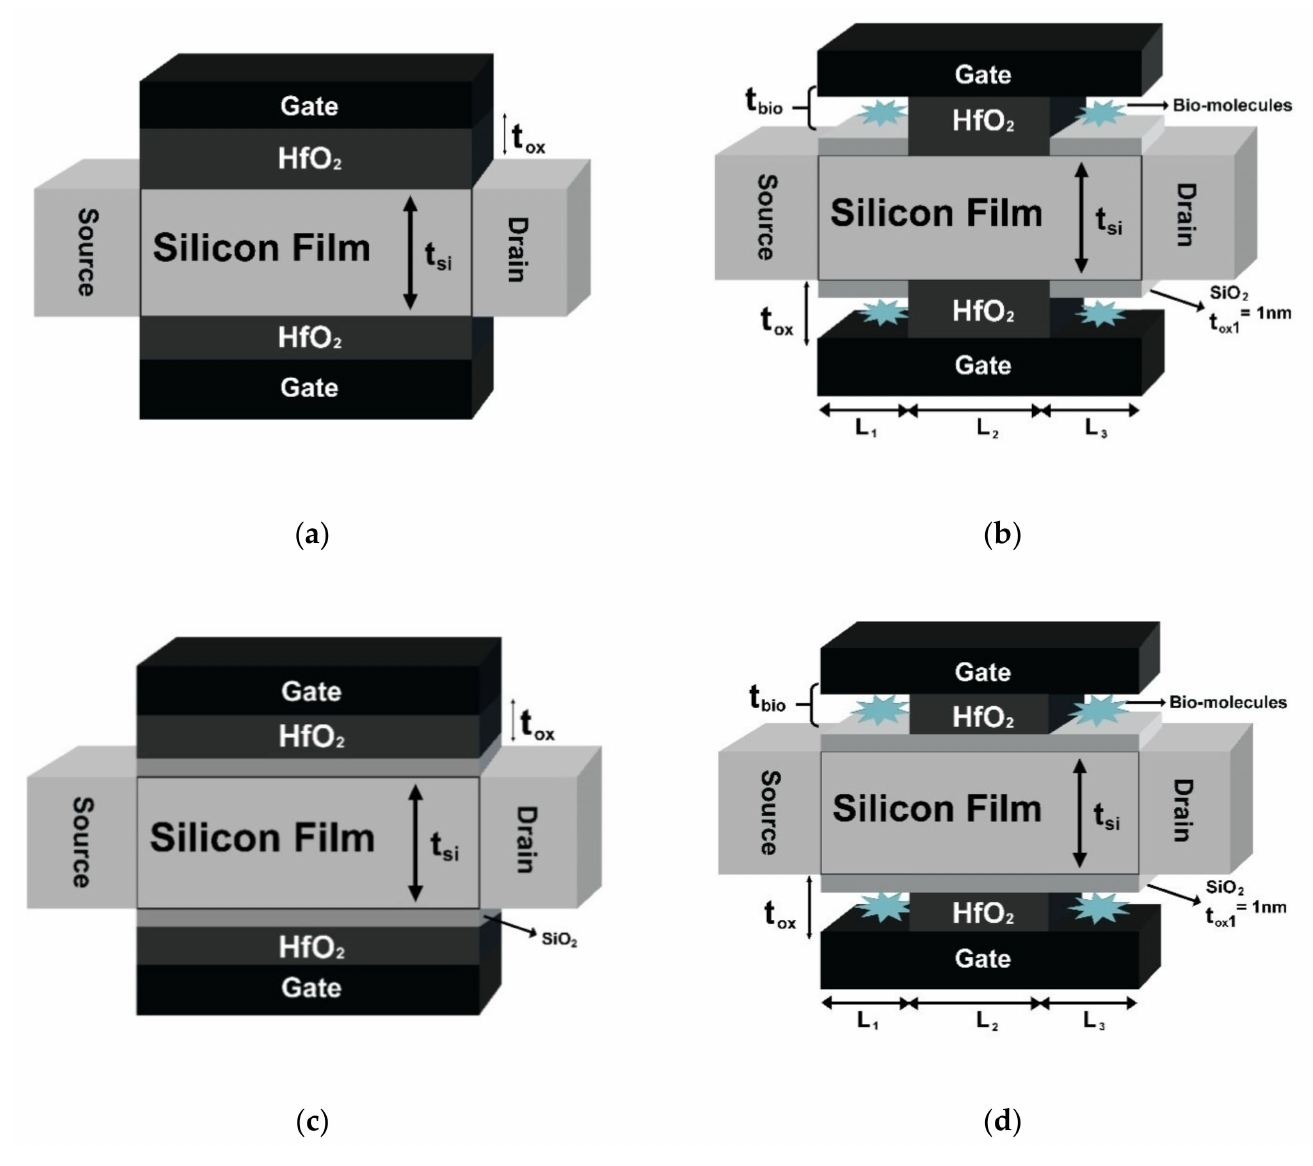
Figure 1. Device structure of ( a ) n-type junctionless DM-DG-MOSFET; ( b ) n-type junctionless DG- MOSFET-based biosensor with cavity; ( c ) n-type junctionless DM-GSDG-MOSFET; ( d ) n-type junc- tionless DM-GSDG-MOSFET-based biosensor with cavity with channel length of 50